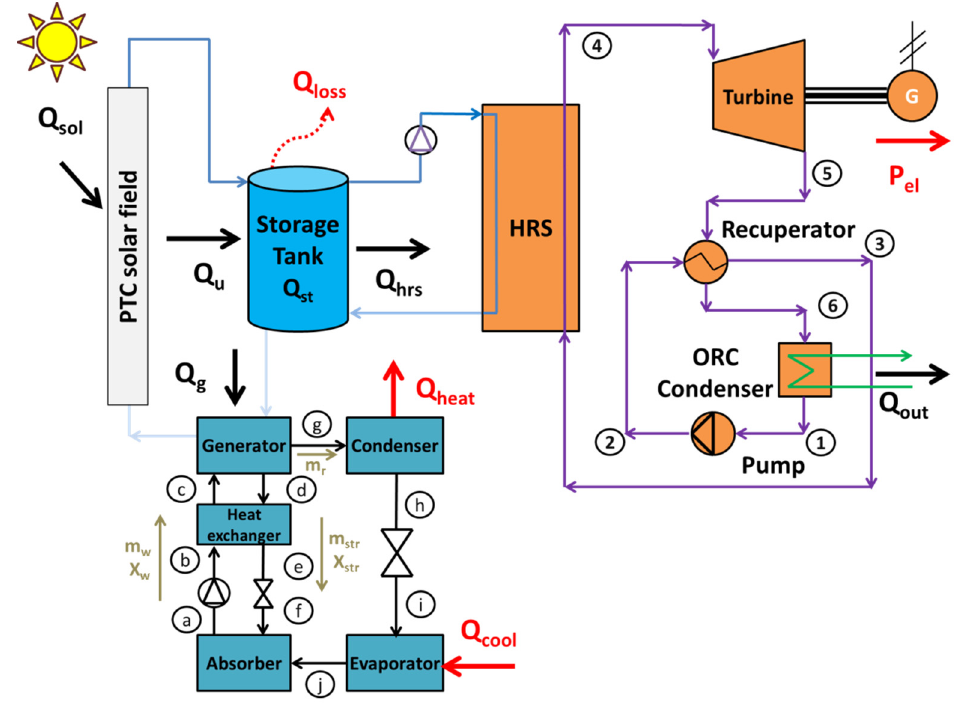
Figure 1. The examined solar-driven trigeneration system.